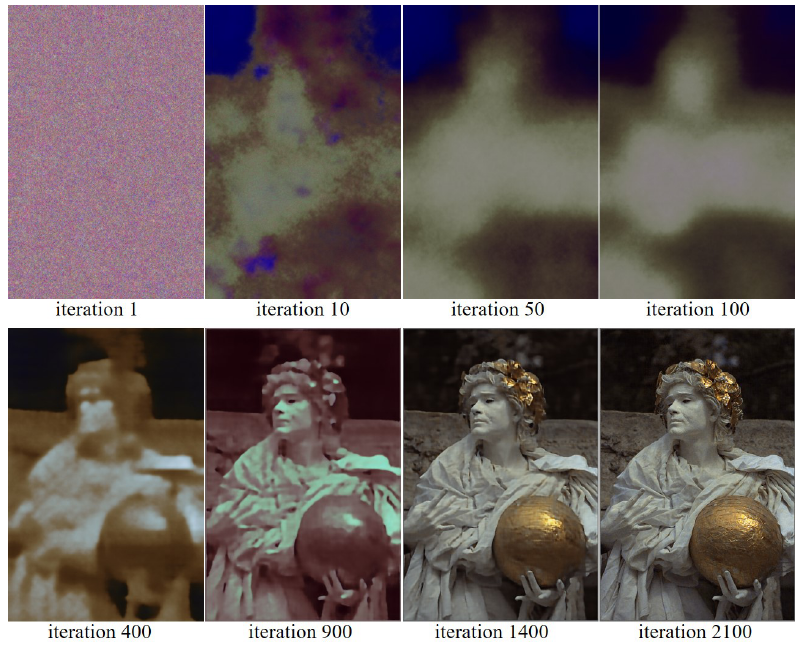
Figure 5. Showing the process of reconstructing the Kodak No. 17 image as the iteration